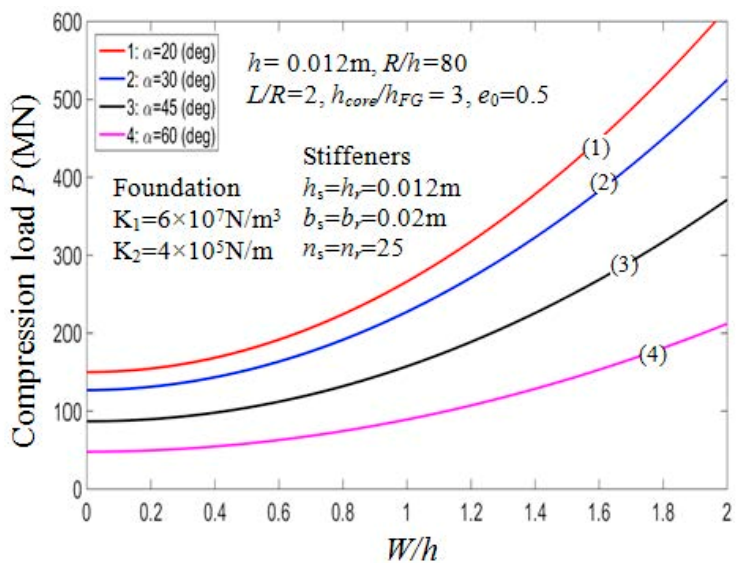
Figure 7. Effects of semi-vertex angle α on postbuckling load—deflection curves (Outside stiffener, k 2 = k 3 = k = 1).